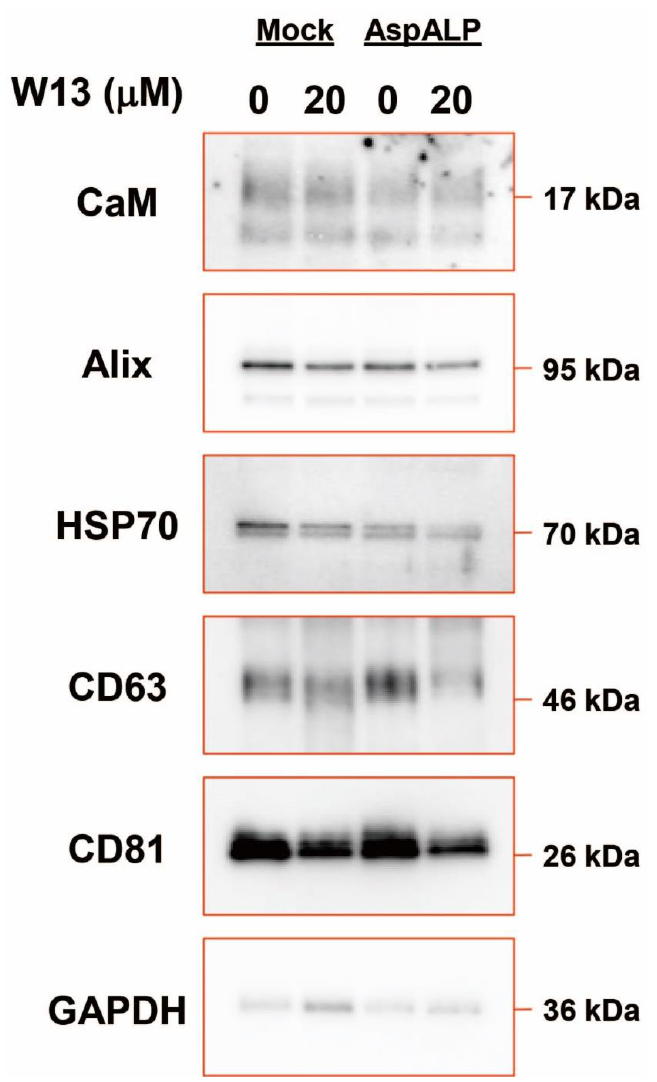
Figure 4. Cargo proteins in exosomes from T-REx cells in the absence or presence of W13. Western blot analysis of cargo proteins from T-REx cells in the absence or presence of W13 for 72 h. An equal amount of protein was loaded. Representative images from three independent experiments.